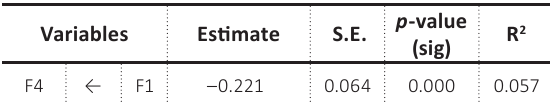
Table 6. Model summary of the main hypothesis Source: Private examination